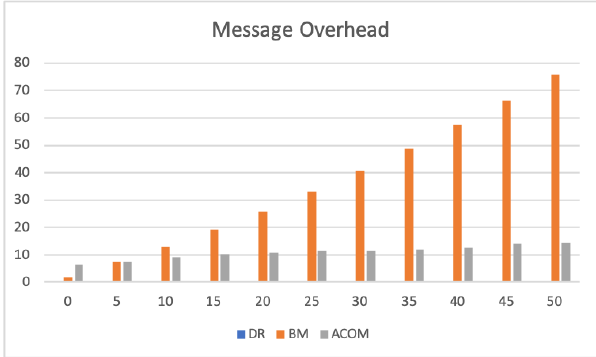
Figure 7. Message overhead of three